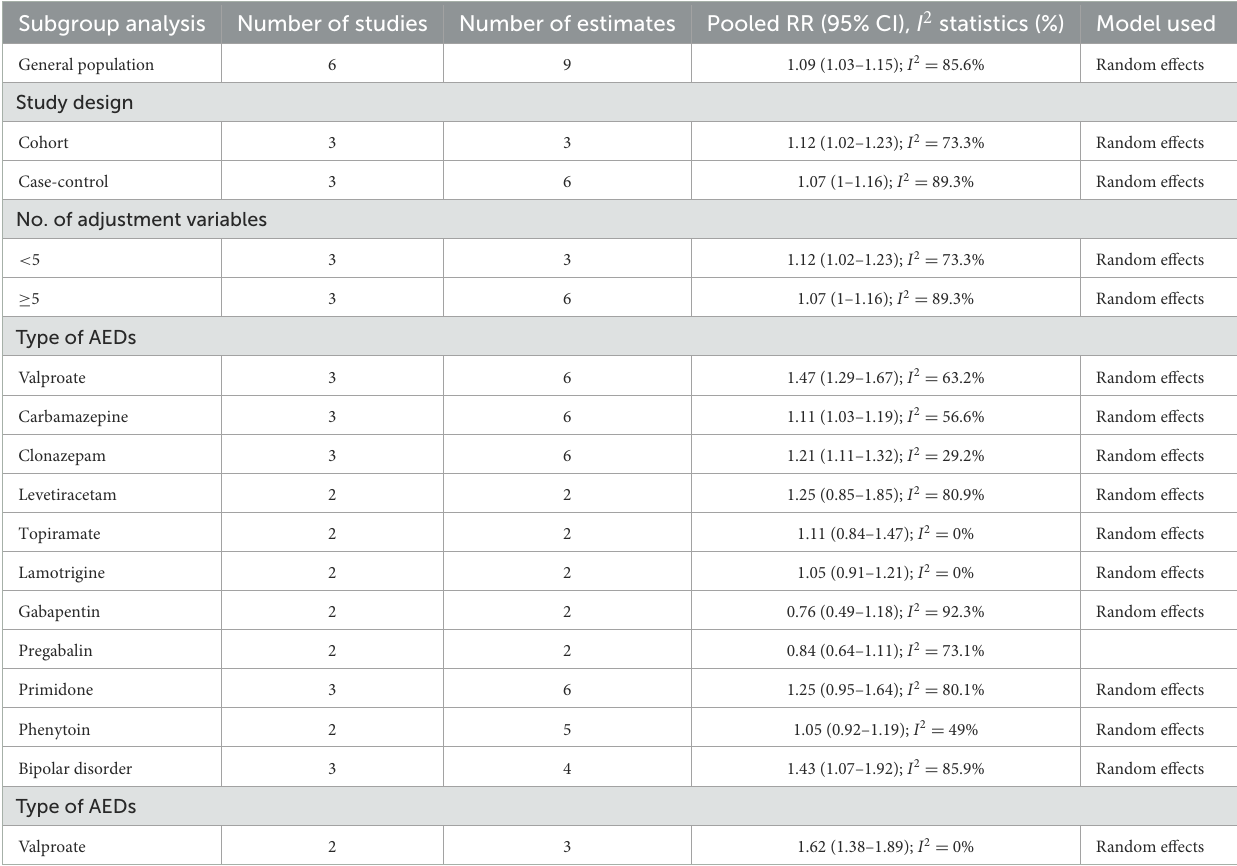
TABLE 2 Meta-analysis for studies included in the